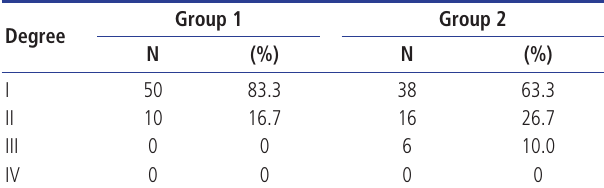
Table 7. Absolute and relative results of the degree of hyperkeratosis in teats of Murrah buffaloes for groups in the beginning of the lactation (1) and at the end